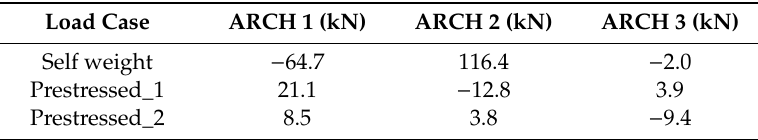
Table 10. Forces on arches with crosspieces of 40 mm.